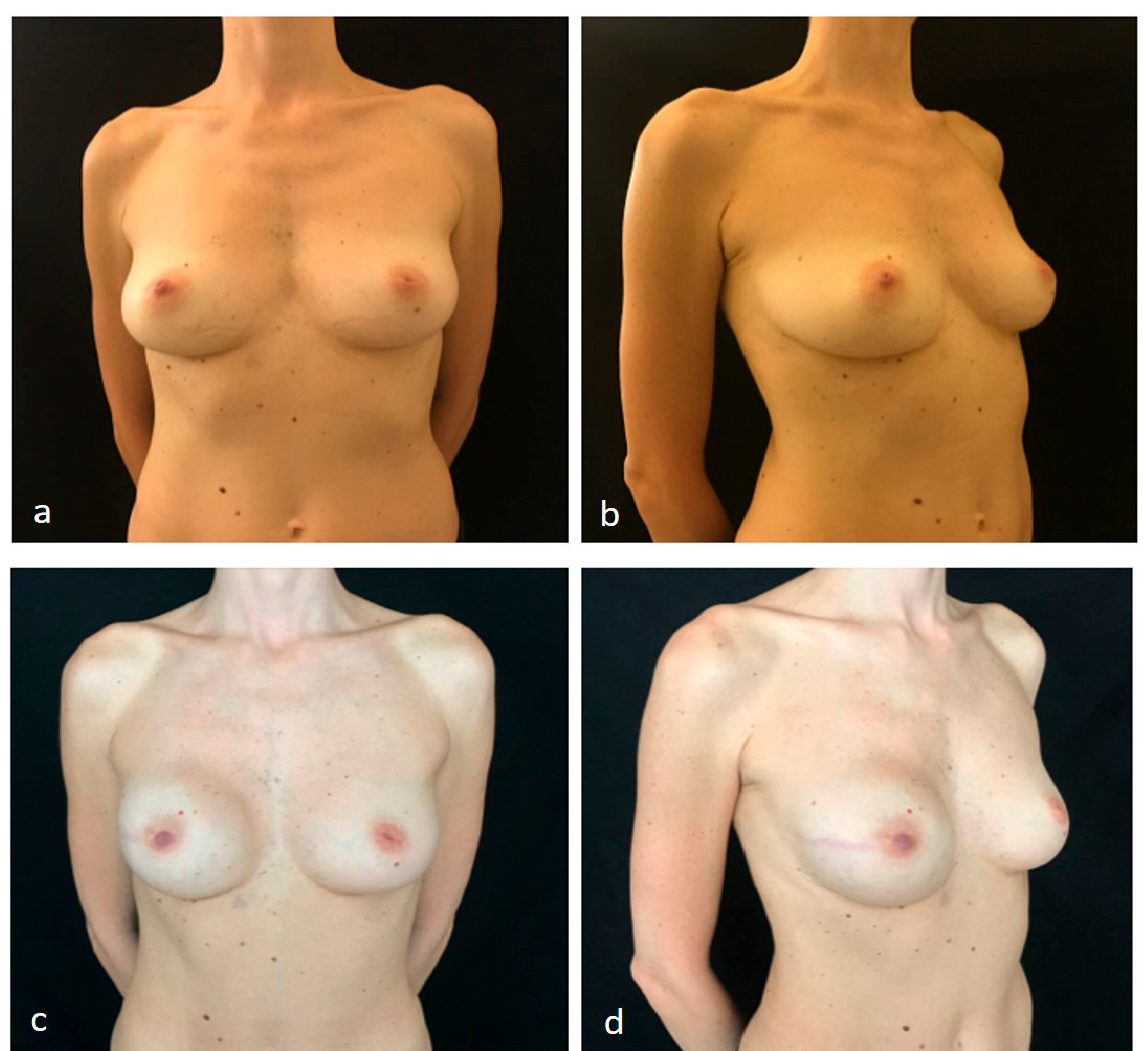
Figure 1. A case of nipple-sparing mastectomy and direct-to-implant prepectoral reconstruction without acellular dermal ma- trix. ( a , b ) Preoperative pictures of a 43-year-old right-breast cancer patient for whom right nipple-sparing mastectomy and direct-to-implant prepectoral reconstruction without acellular dermal matrix were planned. ( c , d ) Six-month postoperative pictures after right nipple-sparing mastectomy through a radial lateral incision (mastectomy specimen 190 g) and prepectoral reconstruction using a definitive anatomical implant (Polytech 30746, 295cc) with a micropolyurethane-foam-coated shell surface, placed in the subcutaneous